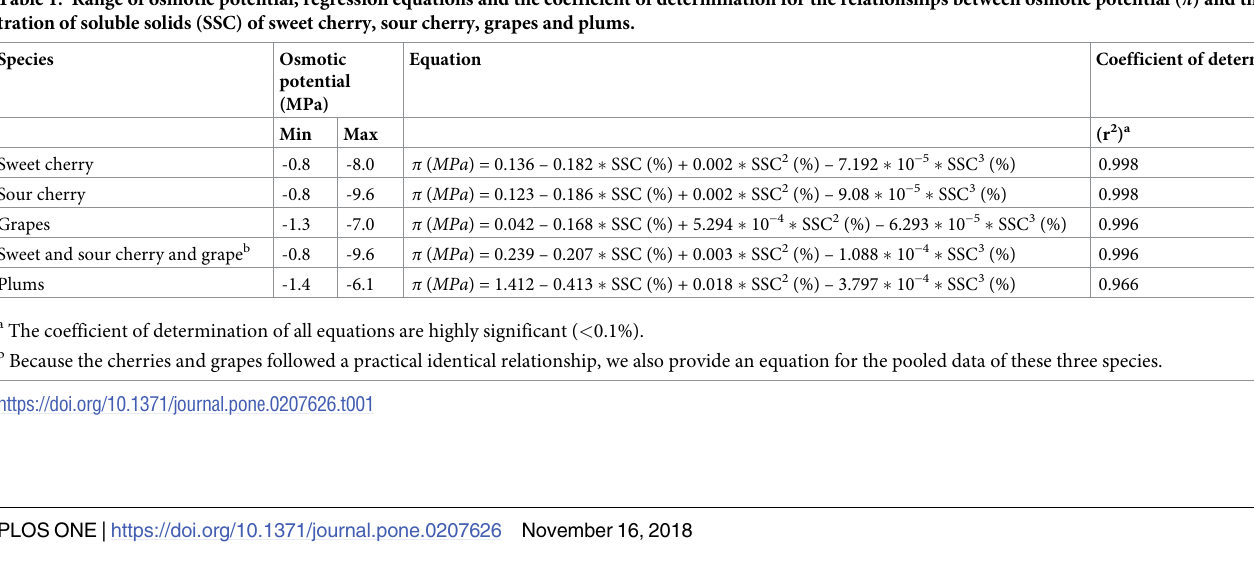
Fig 1. Relationship between soluble solids concentration and osmotic potential for juices of fleshy fruit. Juices were expressed from sweet and sour cherries (A) and grapes and plums (B). C) Regression lines redrawn and superimposed from the relationships depicted in A and B. Osmotic potentials were determined by vapor pressure osmometry, the soluble solids concentrations by refractometry. Data symbols in A and B represent individual fruit. For regression equations see Table 1.